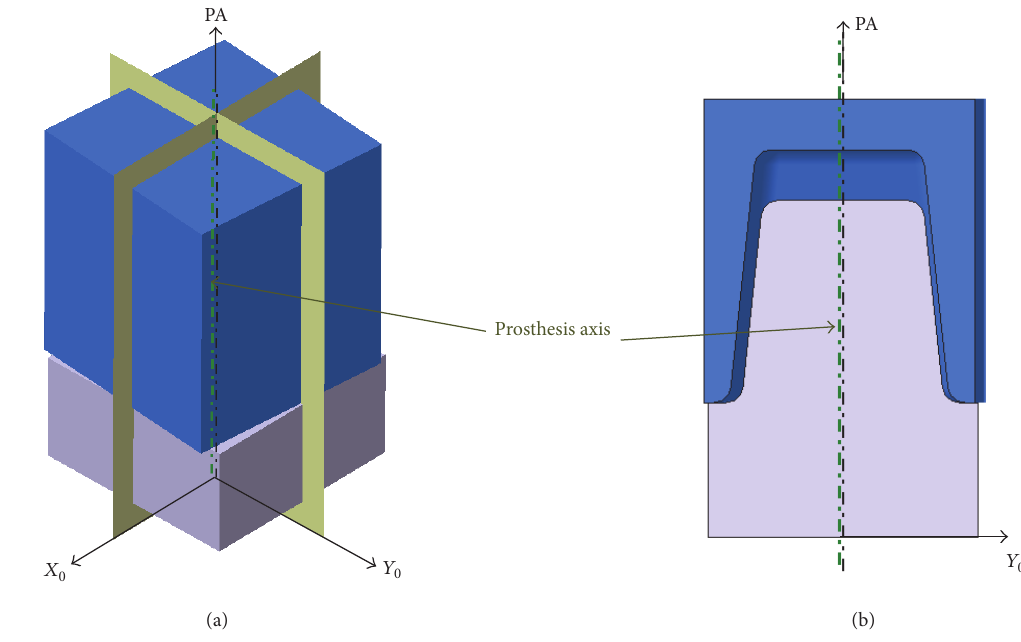
Figure 11: 3D simulation of errors occurring in prosthesis assembly.